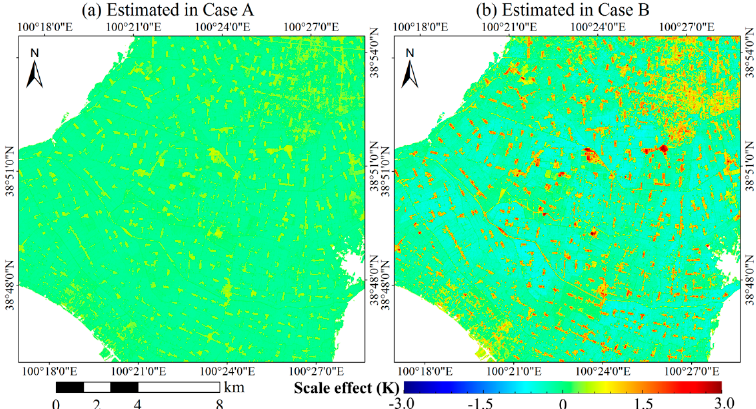
Figure 6. ( a , b ) The estimated scale effect in downscaling the TASI simulated LST with GRM.